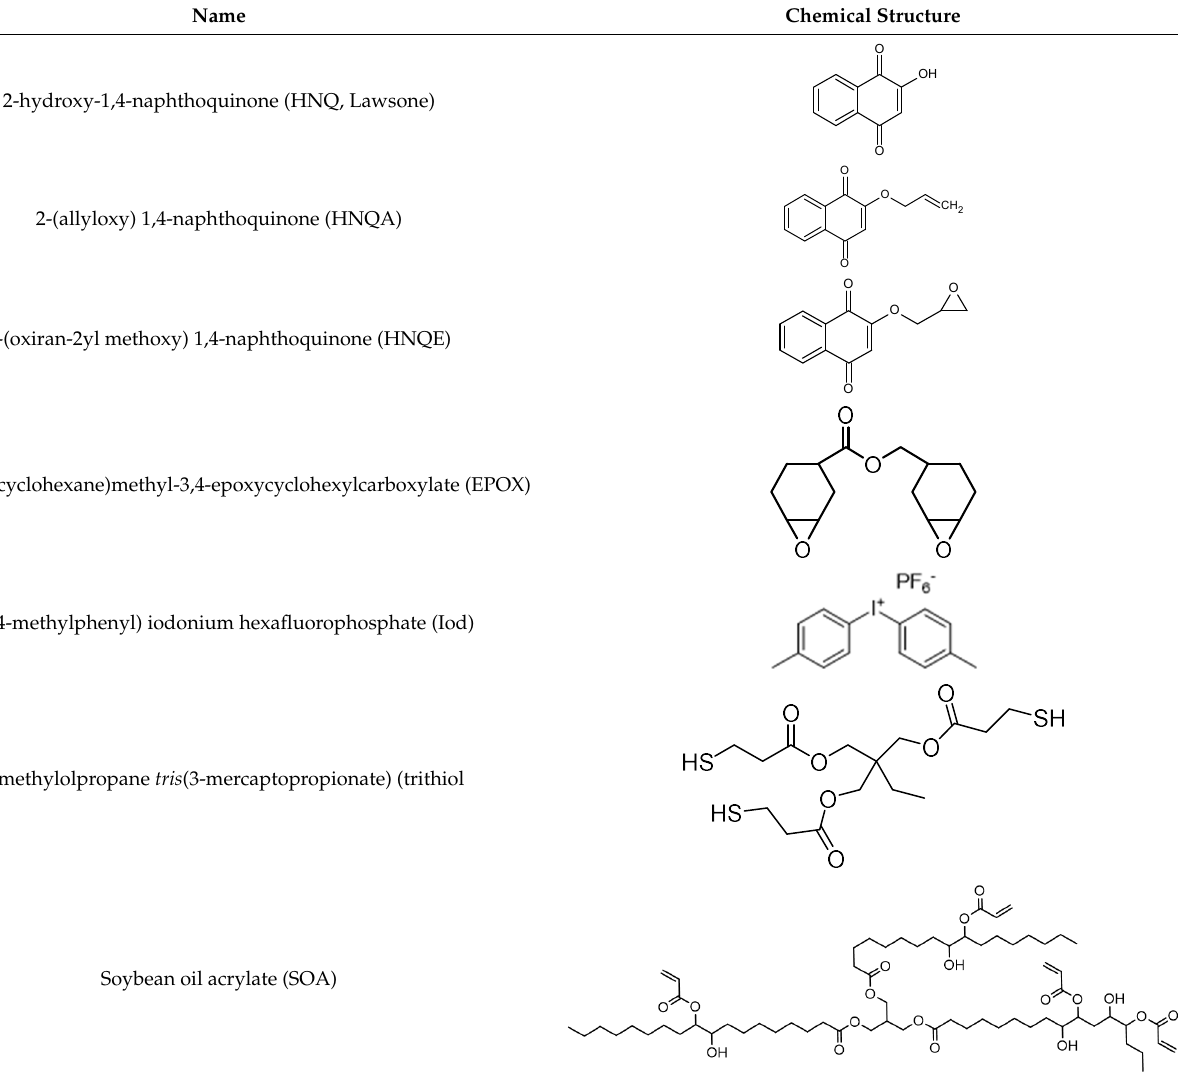
Table 1. Chemical structures of the monomers and photoinitiating systems used in this